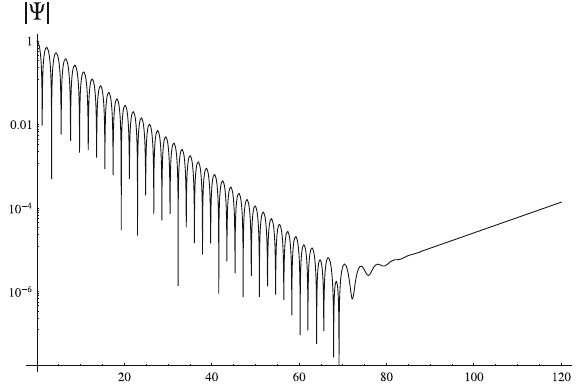
Fig. 3 The time-domain profile of the (cid:11) = 0 scalar perturbations, α = 0 . 1, M = 1 / 2